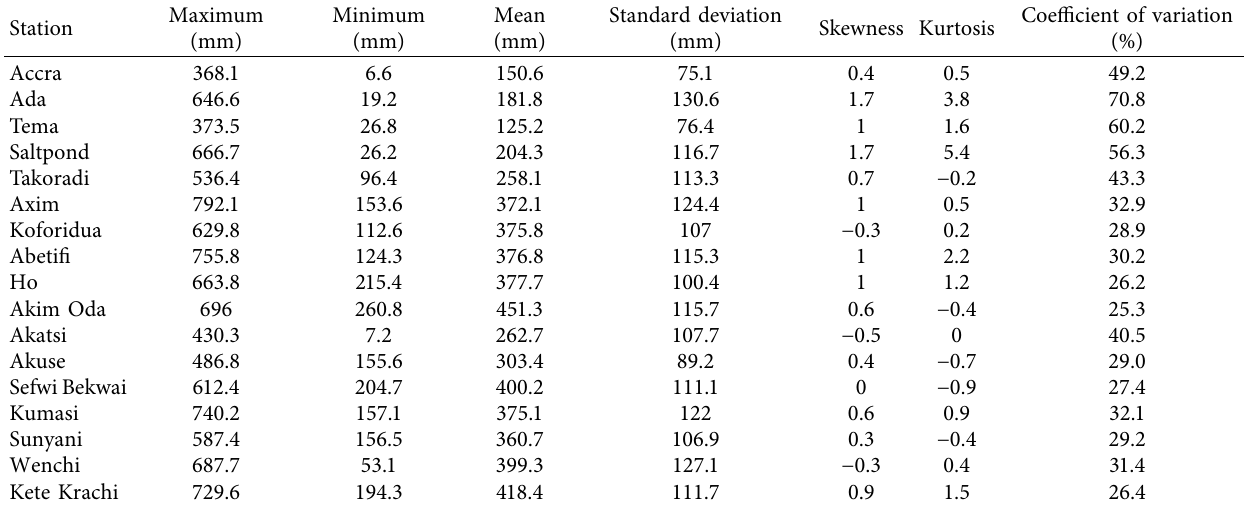
Table 2: Descriptive statistics for the minor season total rainfall in Ghana.